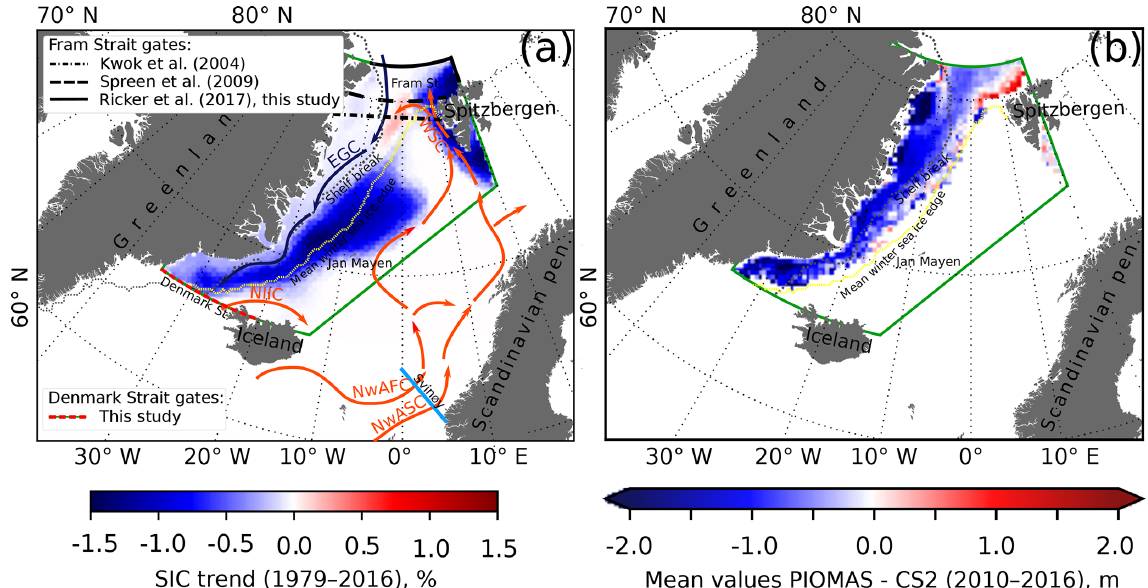
Figure 1. The study region is marked with the green box. (a) Linear trends in the mean October–April NSIDC sea ice concentration (SIC) over the period 1979–2016 (Comiso, 2015). The black lines show gates used for estimation of the sea ice volume flux through Fram Strait. Mean winter sea ice edge is shown with the dashed yellow line, and the shelf break (500m isobath) is shown with the dashed gray line. EGC is the East Greenland Current, NIIC is the North Icelandic Irminger Current, NwAFC is the Norwegian Atlantic Front Current, NwASC is the Norwegian Atlantic Slope Current and WSC is the West Spitsbergen Current. (b) Mean difference between mean PIOMAS and CS2 effective sea ice thickness (m) for October–April